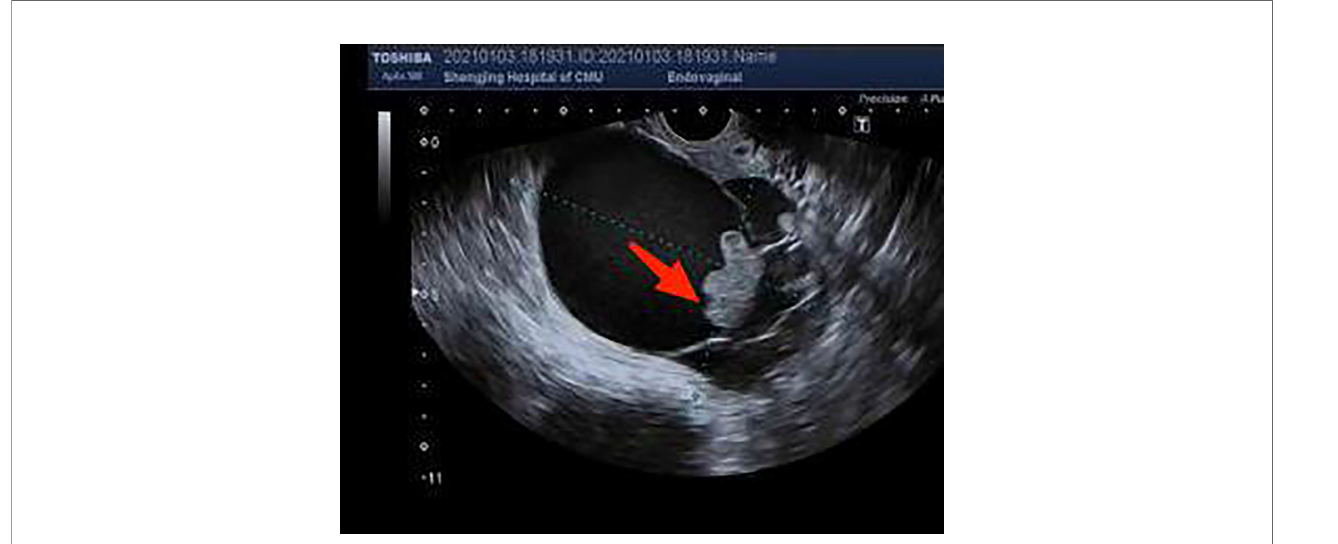
FIGURE 2 | Ultrasound guided microcapsule pattern of borderline ovarian